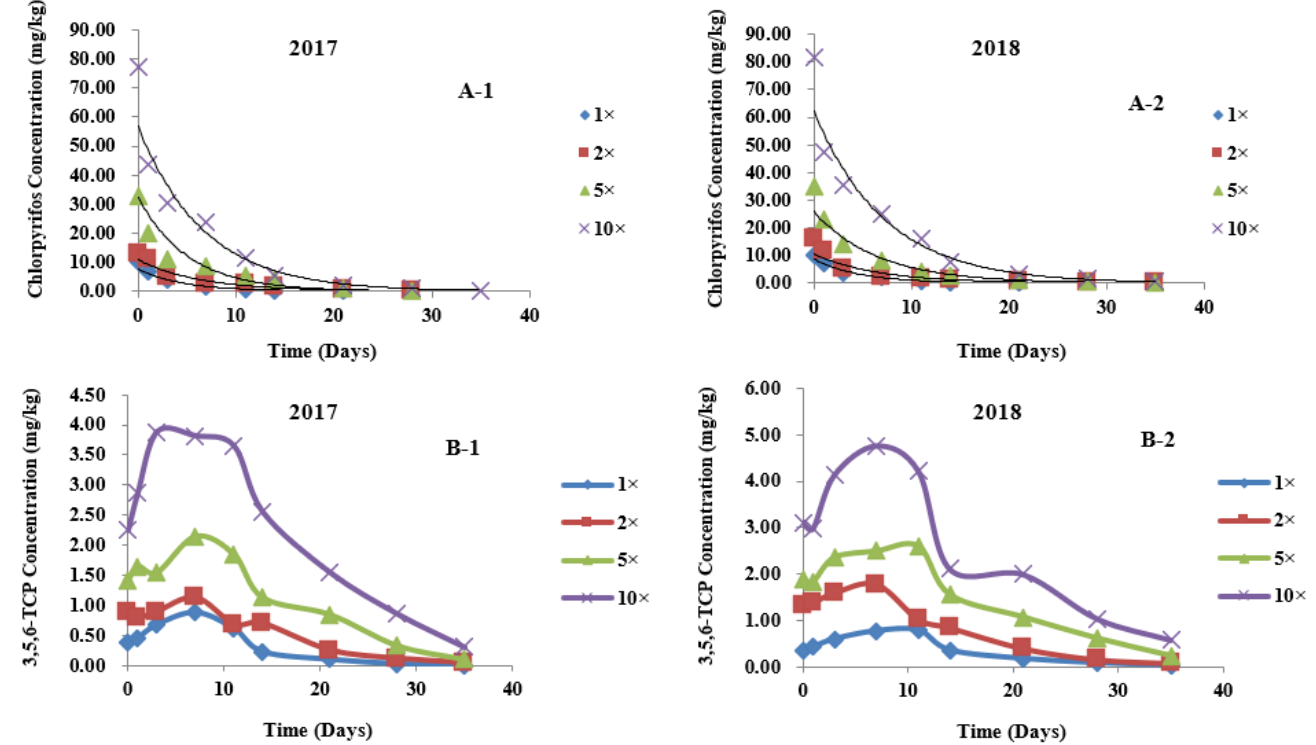
Figure 3. Degradation curves of chlorpyrifos and its metabolite 3,5,6-TCP at different applied dosages in leaves. ( A-1 ) Degradation curves of Chlorpyrifos at different applied dosages in leaves in 2017; ( A-2 ) Degradation curves of Chlorpyrifos at different applied dosages in leaves in 2018; ( B-1 ) Degradation curves of 3,5,6-TCP at different applied dosages in leaves in 2017; ( B-2 ) Degradation curves of 3,5,6-TCP at different applied dosages in leaves in 2018. 1 × : recommended dosage. 2 × : twofold recommended dosage. 5 × : fivefold recommended dosage. 10 × : tenfold recommended dos- age.